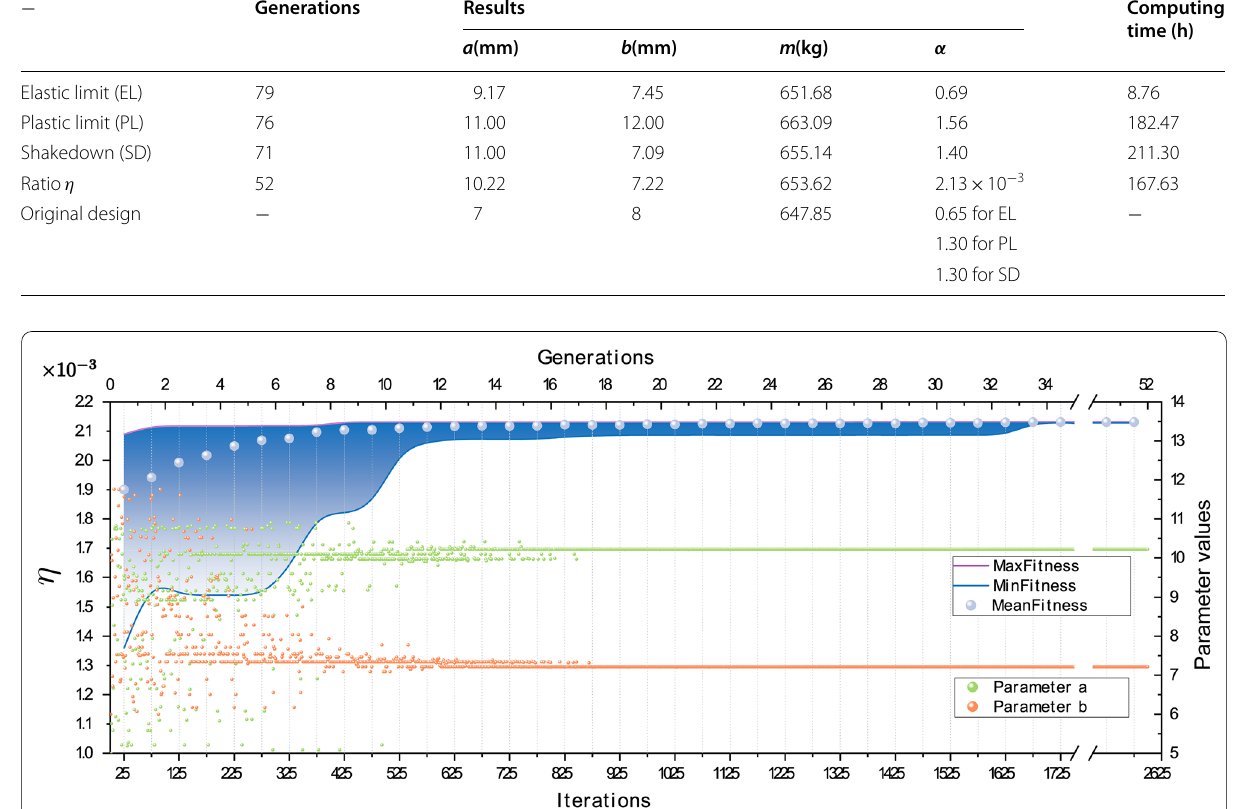
Table 4 Optimization results of manned airtight module and the associated load limit factors −